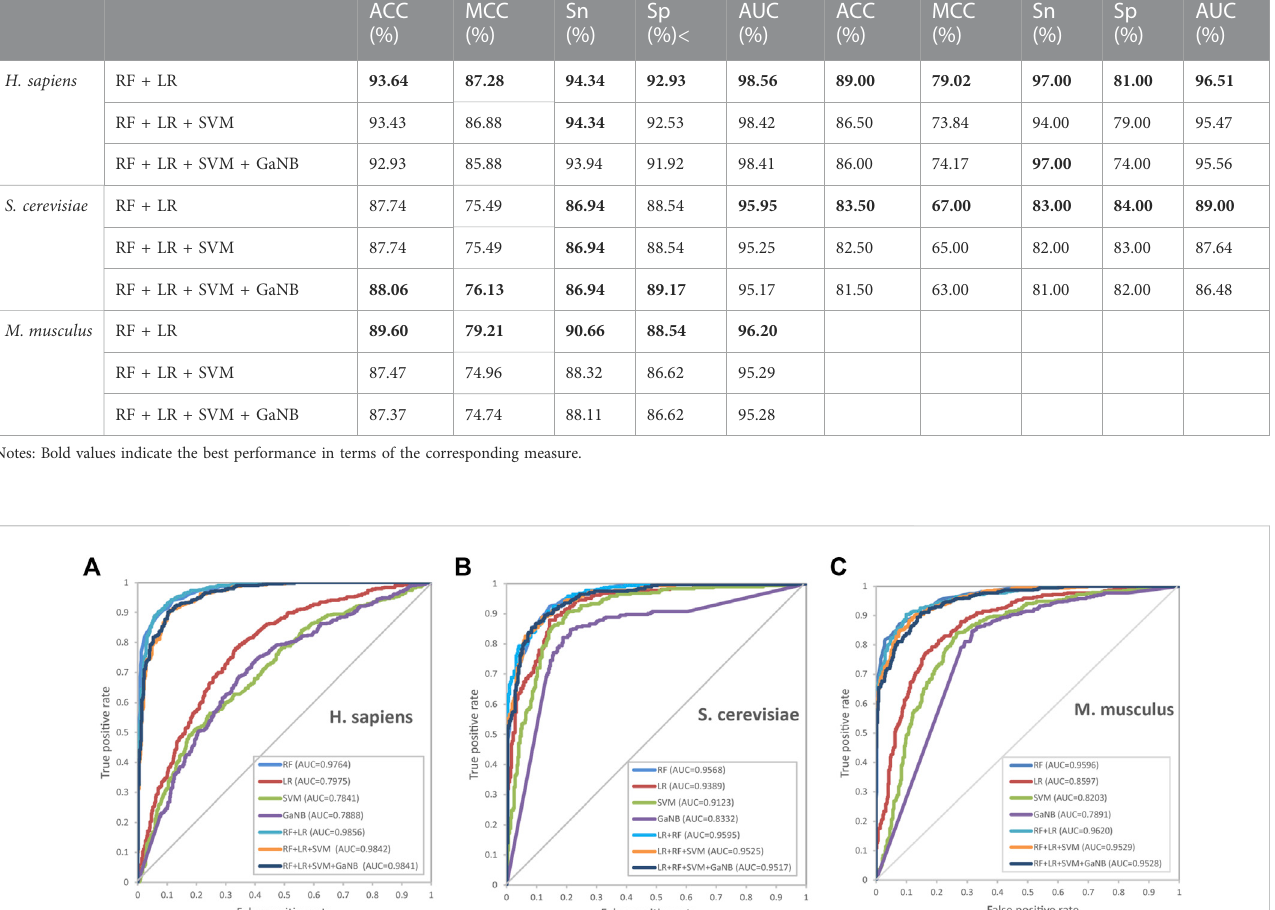
TABLE 3 The performances of the base-classi fi er combinations for the three species. Species Base classi fi ers